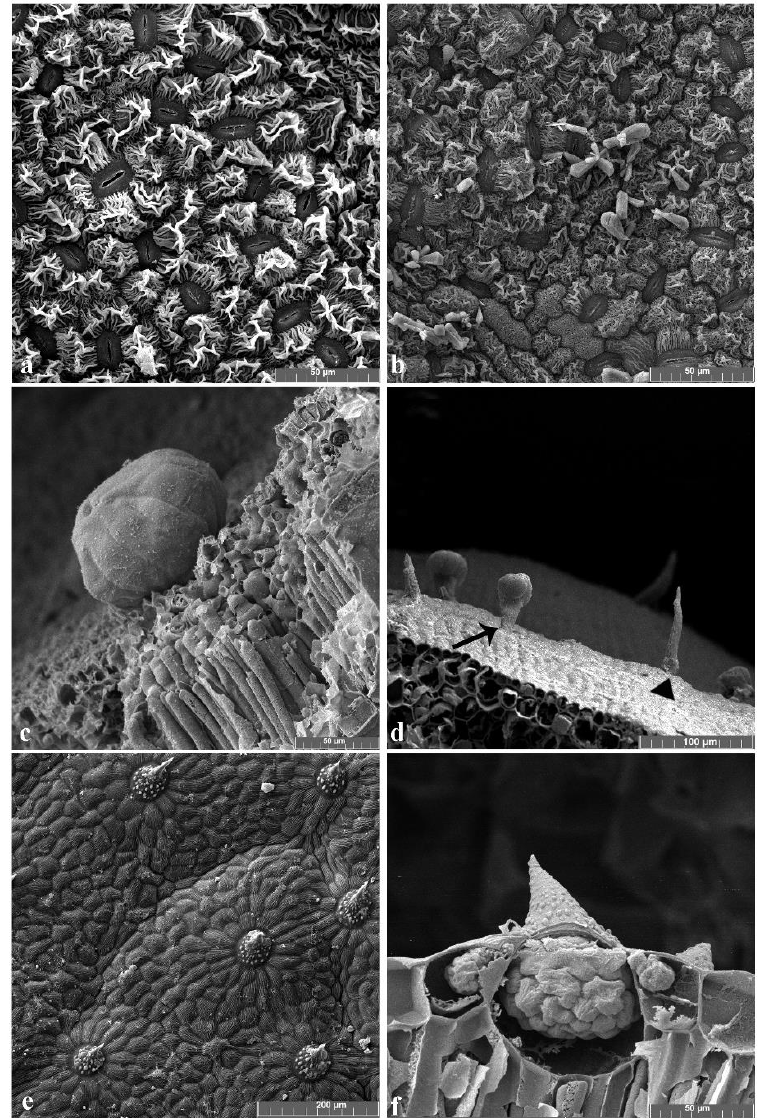
Figure 2. Scanning electron micrographs of hop leaves: ( a ) stomata of untreated leaf in t1; ( b ) stomata of Treat 3 leaf in t1; ( c ) lupulin gland, a large peltate glandular trichome; ( d ) stalked capitate glands (black arrow) and slender non glandular trichome (black triangle), both on the midrib; ( e ) cystolith-containing hairs; ( f ) a section of leaf where is evident the intracellular mineralized inclusion at the base of the trichome (cystolith).